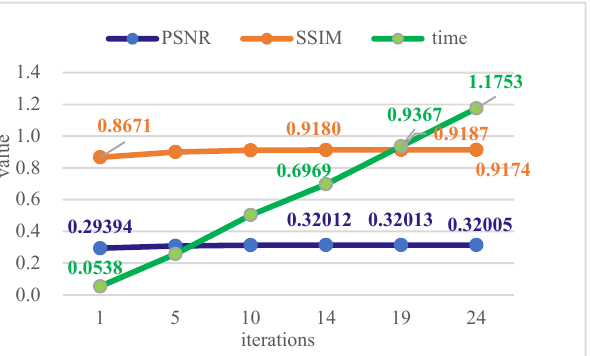
Figure 3. The average PSNR, SSIM values, and running time on the Rain 12 dataset in the experiment increased with the number of iterations.